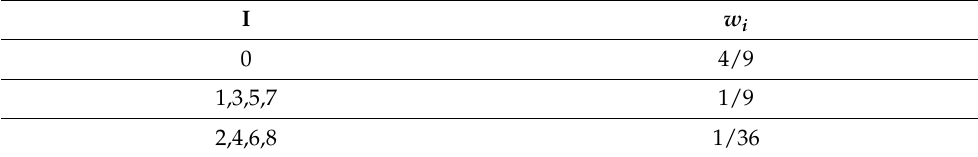
Table 1. Weighting factors for